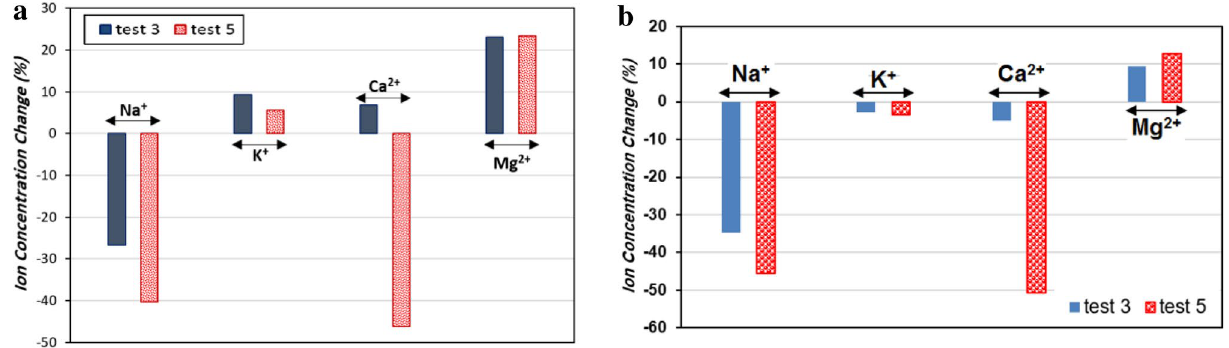
Fig. 10 Percentage of ion concentration change for test 3 (low perme- able reservoir carbonate rock, S wc = 0.25, k = 0.4 mD) and test 5 (high permeable outcrop carbonate rock, S wc = 0.25, k = 185 mD). Left pic- ture ( a ) depicts the percentage of ion concentration change and right